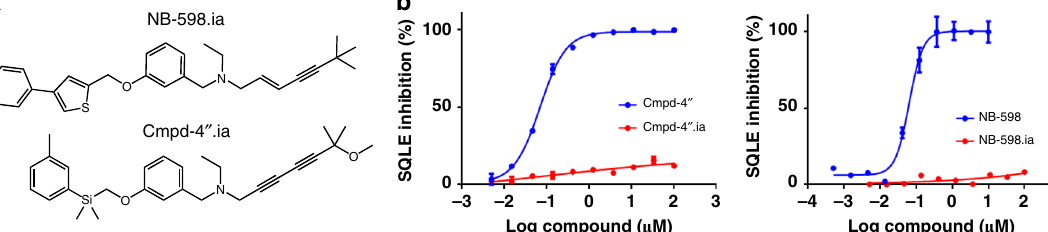
Fig. 4 Biochemical activity of SQLE inhibitors and their inactive analogs. a Structures of inactive analogs, NB-598.ia and Cmpd-4 ′′ .ia. b NB-598 inhibits baculosome-derived SQLE with an IC 50 of 63 nM, while the structural analog NB-598.ia has an IC 50 of >100 μ M (left panel) and Cmpd-4 ′′ inhibits baculosome-derived SQLE with an IC 50 of 69 nM, while the structural analog Cmpd-4 ′′ .ia has an IC 50 of >100 μ M (right panel). Points and error bars are the mean and standard deviation of triplicate amino acids (F166, I197, and L324) positioned near the aromatic terbina fi ne using NB-598 template in human SQLE positions the side of the inhibitor were not conserved between the species naphthalene group adjacent to bulkier hydrophobic side chains of (Fig. 3c), while the amino acids near the linker and the aliphatic I197 and L324. These sub-optimal non-polar contacts are con- side were identical between human and fungal SQLE. The aro- sistent with the observed higher IC 50 values of terbina fi ne in the HLM enzymatic assay. Interestingly, residues corresponding to matic side of terbina fi ne contains bulkier naphthalene group in I197 and L324 in dermatophyte SQLE are smaller hydrophobic the position of benzene linker of NB-598. Modeling the